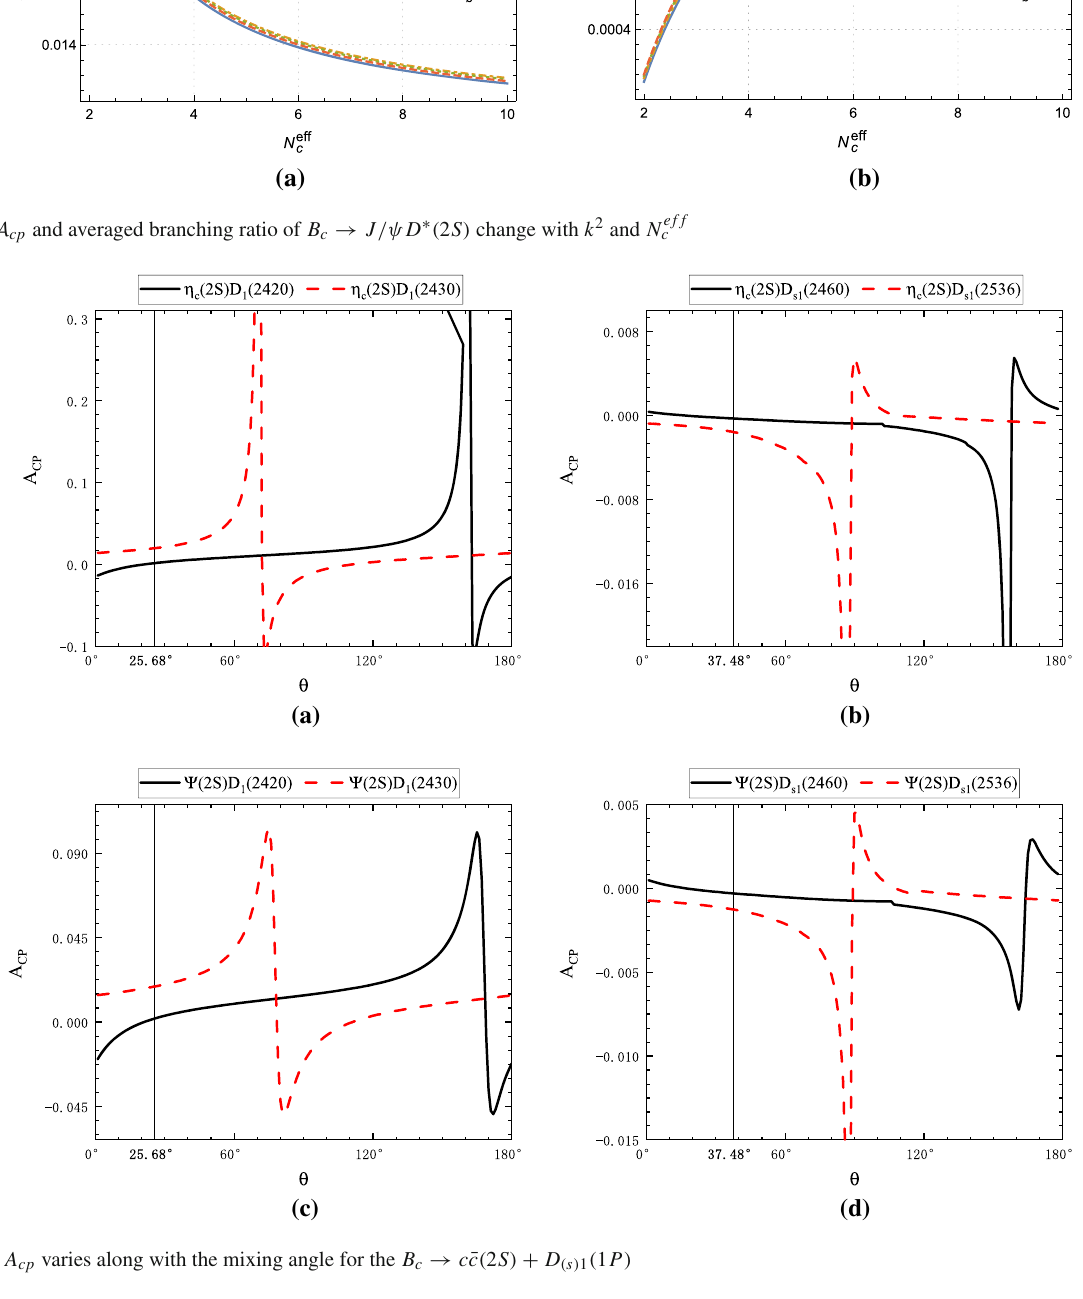
Fig. 10 A cp varies along with the mixing angle for the B c → c ¯ c ( 2 S ) + D ( s ) 1 ( 1 P